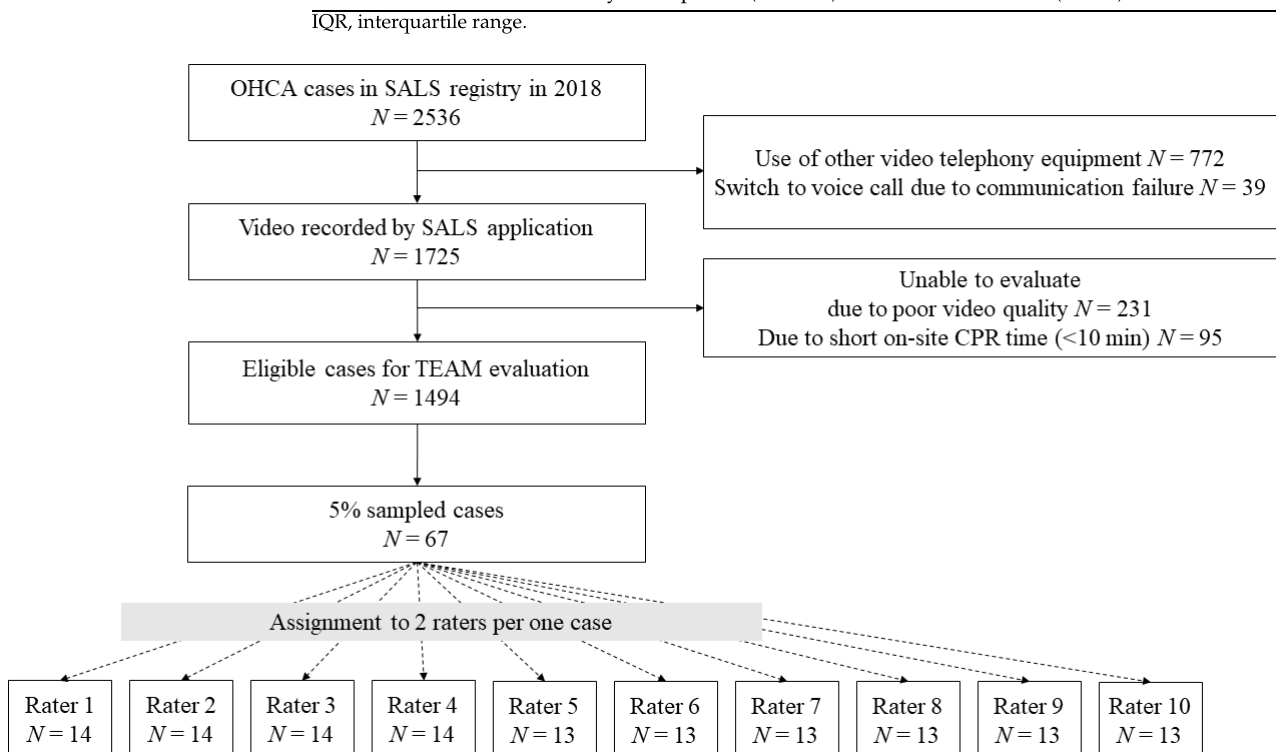
Figure 1. Flowchart of selection of eligible cases and allocation to raters. Abbreviations: OHCA, out-of-hospital cardiac arrest; SALS, Smart Advanced Life Support; CPR, cardiopulmonary resuscitation; TEAM, Team Emergency Assessment Measure.